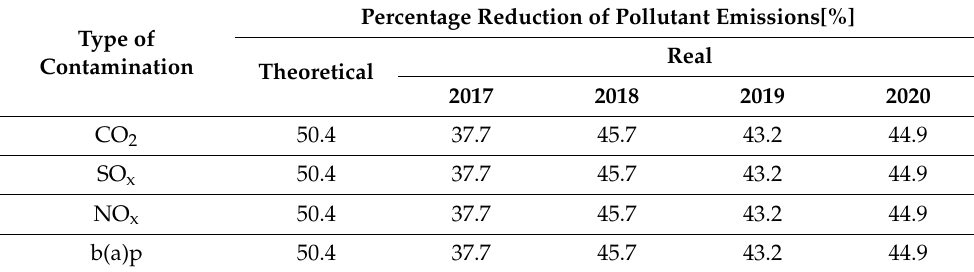
Table 13. Percentage reduction of pollutant emissions after thermomodernization in the building A on the basis of the theoretical model and measurement method of thermal energy consumption.